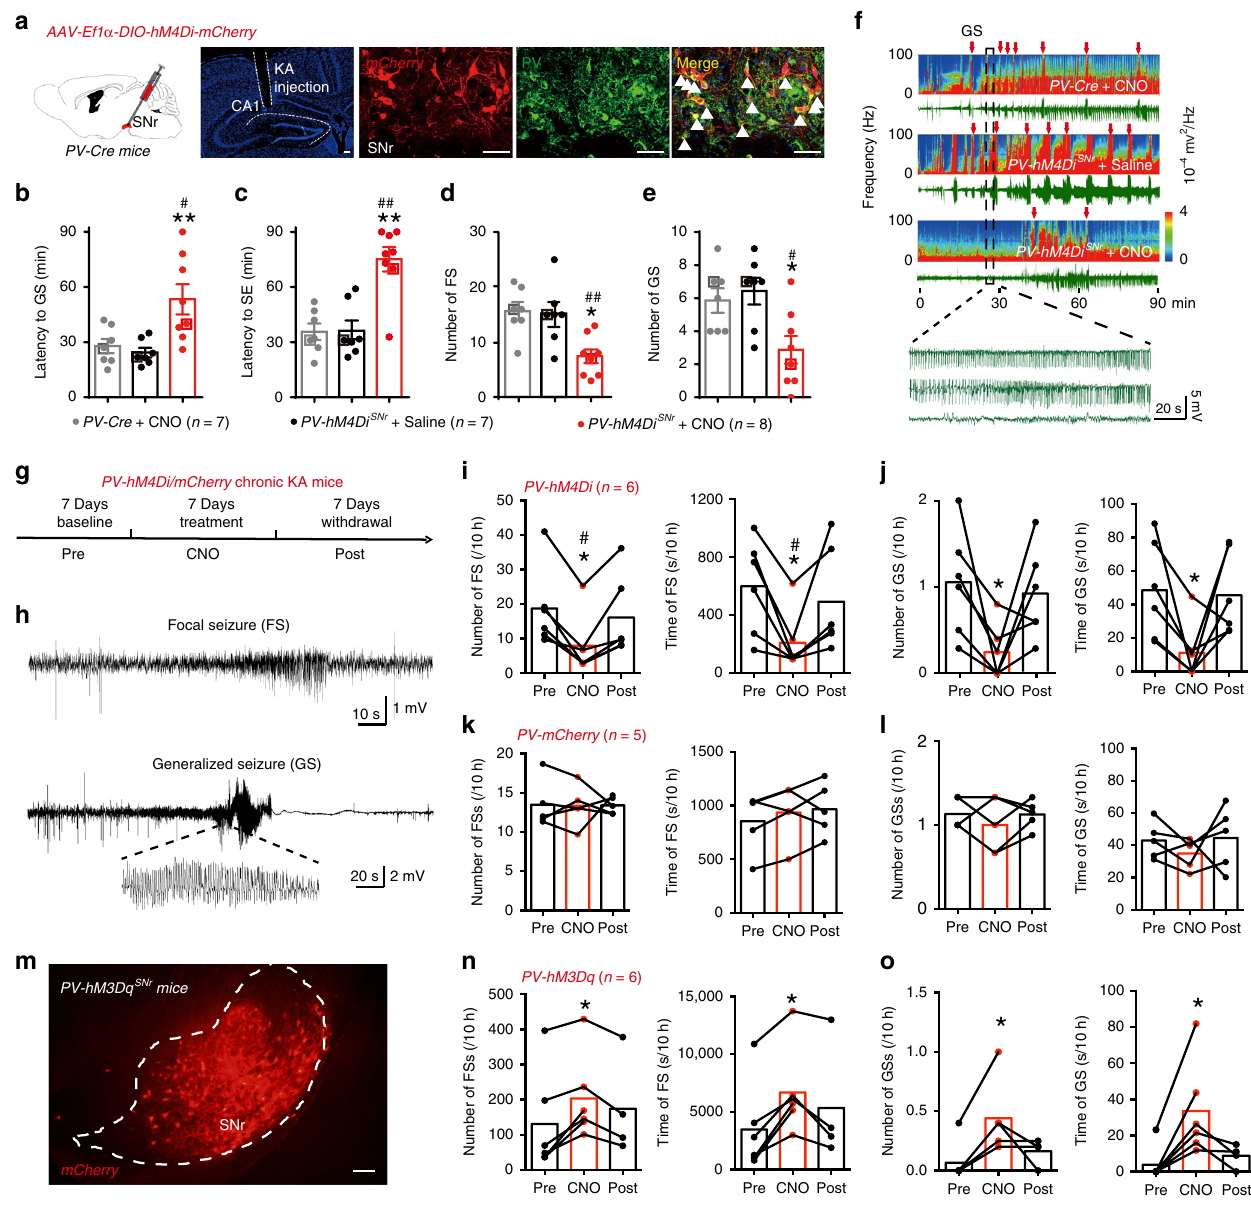
Fig. 3 SNr PV neurons bidirectionally modulate the severity of epileptic seizures in kainic acid (KA)-induced spontaneous seizure model. a Left, scheme of experiment for viral injection in PV-hM4Di SNr mice. Middle, coronal section showing the placement of guide cannula in dorsal hippocampal CA1 for kainic acid injection (Blue, DAPI). Right, representative images of the SNr from a PV-hM4Di SNr mouse, showing the overlap of mCherry (red) and PV neurons (green). Scale bar, 50 μ m. b – e Effects of chemogenetic inhibition of SNr PV neurons on the latency to generalized seizure (GS, b ), latency to status epilepticus (SE, c ), the number of focal seizures (FSs, d ), and GSs ( e ) in KA-induced acute seizure model. Kruskal – Wallis test with post-hoc Dunn ’ s test for multiple comparisons; * P < 0.05, ** P < 0.01 compared with PV-hM4Di SNr with saline; # P < 0.05, ## P < 0.01, compared with PV-Cre with CNO. f Representative EEG spectra power and raw EEG after KA injection; below are enlarged raw EEG segments corresponding to the dotted boxes. Red arrowheads indicate GS onsets. g Scheme of experiment for CNO treatment in KA-induced chronic epileptic PV-hM4Di SNr mice. h Typical spontaneous FS and GS in chronic epileptic PV-hM4Di SNr mice. i , j Effects of chemogenetic inhibition of SNr PV neurons on the number and duration of FSs ( i ) and GSs ( j ) in KA-induced chronic epileptic model. Wilcoxon ’ s matched-pairs test, * P < 0.05 compared with Pre; # P < 0.05 compared with Post. k , l Effects of CNO treatment on the number and duration of FSs ( k ) and GSs ( l ) in KA-induced chronic epileptic PV-mCherry SNr mice. m Representative image of the SNr from a PV-hM3Dq SNr mouse showing the expression of mCherry (red). Scale bar, 50 μ m. n , o Effects of chemogenetic activation of SNr PV neurons on the number and duration of FSs ( n ) and GSs ( o ) in KA-induced chronic epileptic PV-hM3Dq SNr mice. Wilcoxon ’ s matched-pairs test, * P < 0.05 compared with Pre. The number of mice used in each group is indicated in the fi gure. Data are presented as means ± SEM. Source data are provided as a Source Data fi